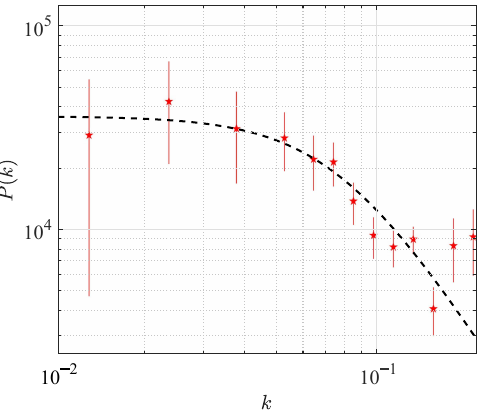
Figure 4. Same as in Figure 3 for data from [31] with A = 35.9332, b = 0.882462, c = 0.999, α = 2.58324. Adapted with permissions from IOP Publishing [31]. Copyright 2004 IOP